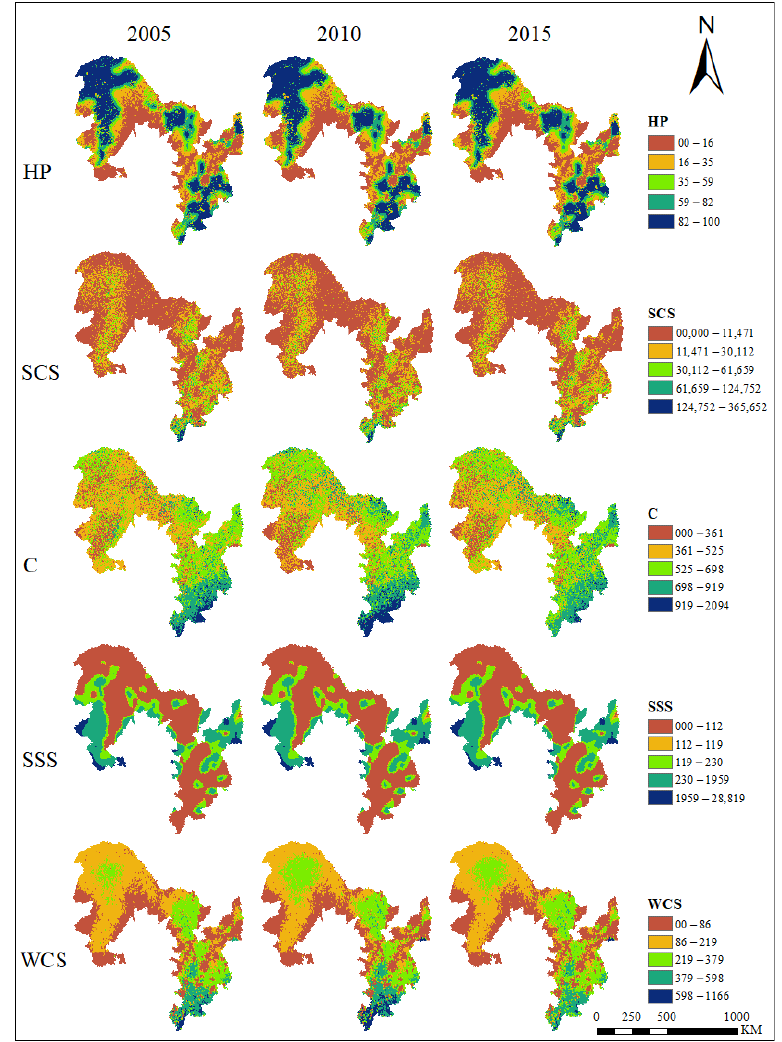
Figure 9. Spatial distribution of five types of ES at different levels in the NFB from 2005–2015. Note: HP is habitat provision service, SCS is soil conservation service, C is carbon sequestration service, SSS is sand-stabilization service, and WCS is water conservation service.